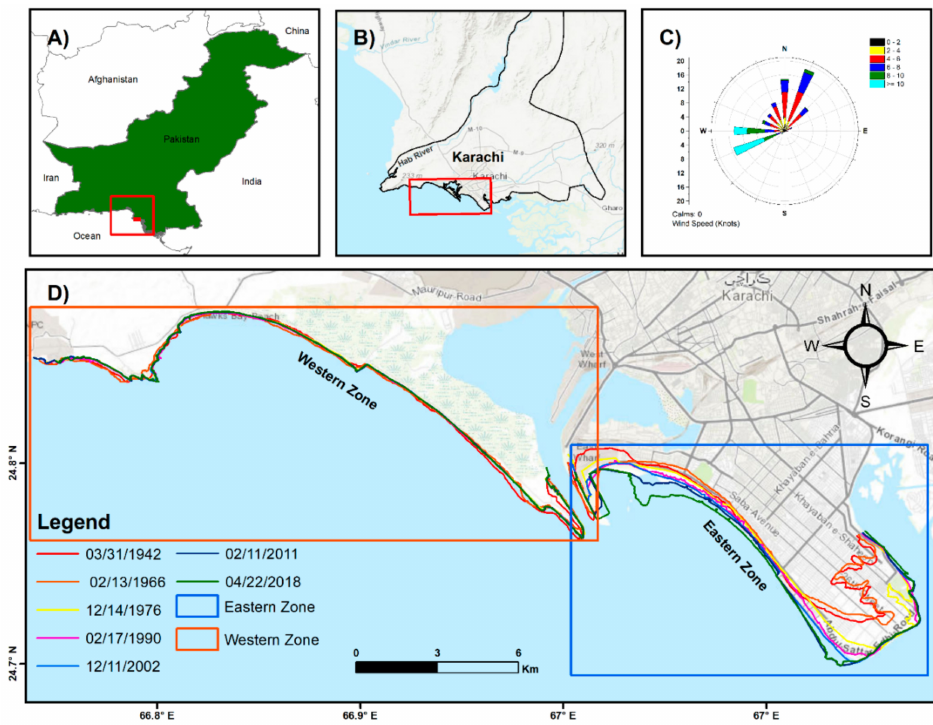
Figure 1. ( A ) Map of Pakistan with a demarcation of the study area (filled red rectangle). ( B ) Geographical location of the coastal city, Karachi, where the red rectangle shows the study area. ( C ) Wind climatology of the study area and ( D ) historical shoreline positions of the Karachi coast in the eastern and western